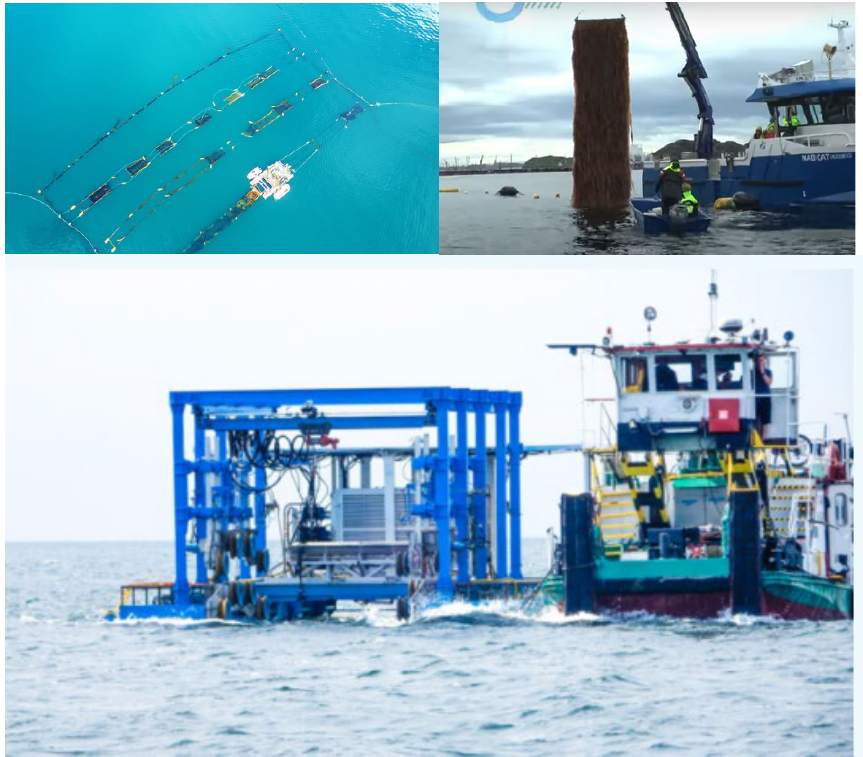
Figure 18. The 2D Fabric substrate system and harvesting machine—images—https://atseanova.com/ (accessed on 22 September 2022).